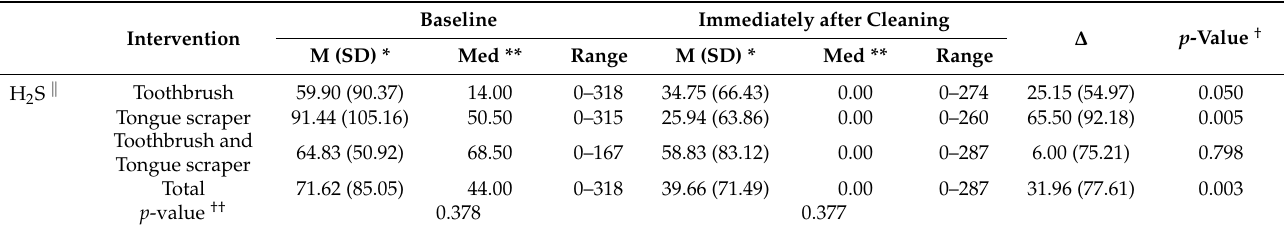
Table 7. Portable sulfide monitor score (H 2 S).